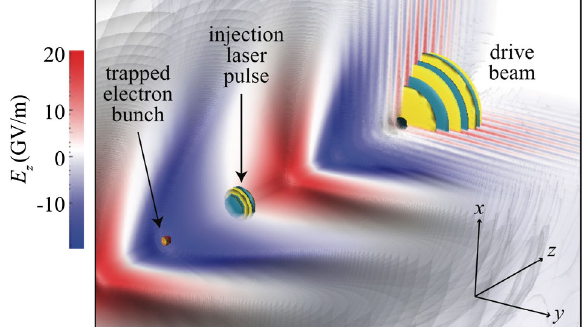
FIG. 1. Illustration of (two-color) laser-ionization injection from a 3D PIC simulation: a drive beam (a circular-polarized, 5 μ m-wavelength laser pulse with a duration, and spot size w 0 ¼ 36 μ m) is propagating in the ˆ z direction in a plasma of density n 0 ¼ 2 × 10 17 cm − 3 doped with a high- Z gas (Krypton), and generates a plasma wave (wake), E An injection laser pulse (linear-polarized with λ ¼ 0 . 135 , 16 fs FWHM duration, and spot size w a i is copropagating and delayed with respect to the beam driving the plasma wave such that ionized electrons (Kr 8 þ to Kr 9 þ ) are trapped in the wake forming a trailing accelerated electron